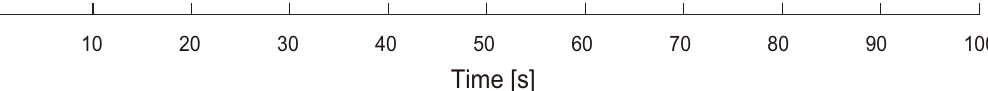
Figure 4. Decoding results using 32 electrodes selected with the location-based method for monkey B. Example of 3D hand trajectory prediction over 100 s of test data using 32 channel ECoG signals. R 2 values between the predicted (blue) and observed (red) trajectories for X-, Y-, and Z-positions are shown.